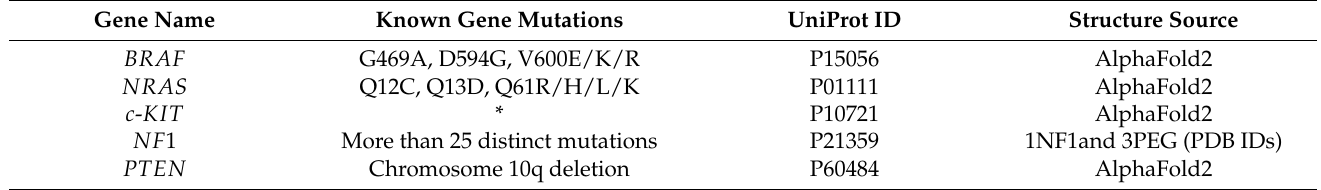
Table 1. Genes with mutations known to be associated with the development of conjunctival melanoma.